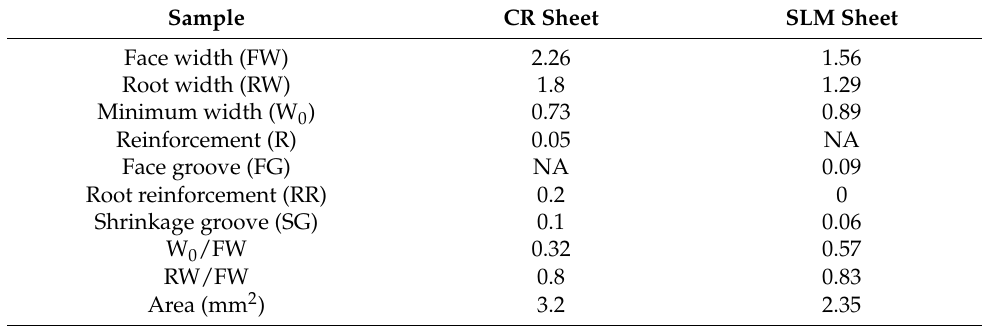
Table 5. Seam geometrical description.